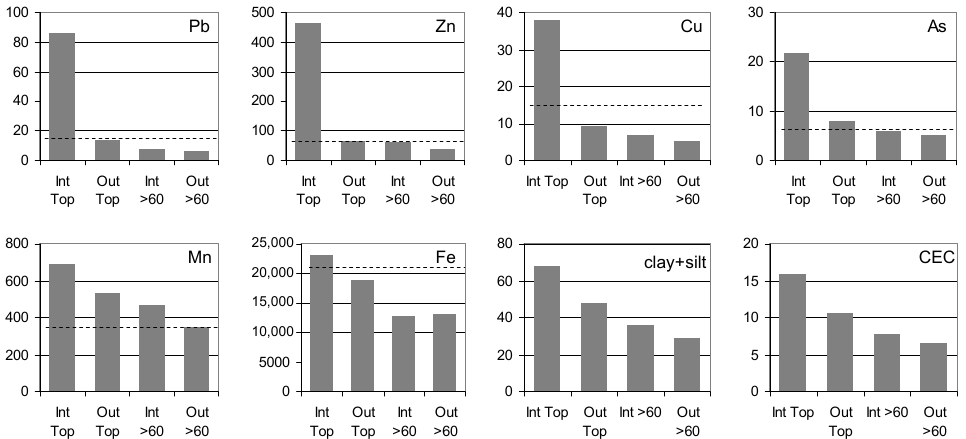
Figure 4. Mean concentrations of metal(loid)s: Pb, Zn, Cu, As, Mn and Fe in soils (mg/kg), as well as the mean values of clay + silt content (%) and CEC (cmol(+)/kg). Median values reported by FOREGS (Table 3) for European subsoil are shown with dashed lines.